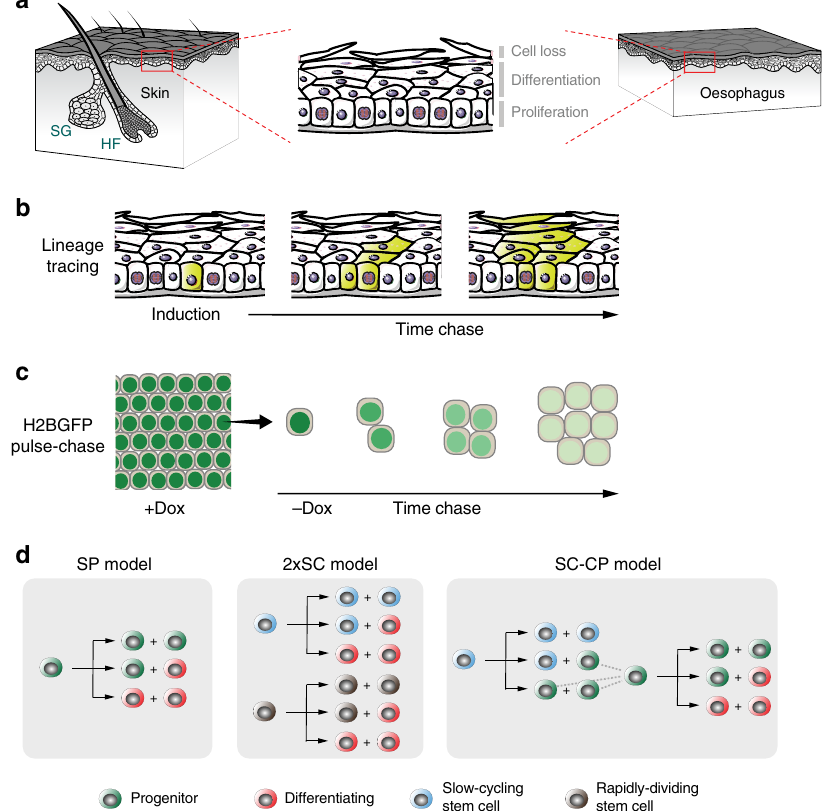
Fig. 1 Quantitative approaches to cell behavior in murine epithelium. a Structure of the strati fi ed squamous epithelia from the interfollicular epidermis (skin) and esophagus of adult mice. Proliferating keratinocytes are located in the basal layer. Upon differentiation they migrate through suprabasal layers until they are ultimately lost by shedding. A balance should be established between cell division and cell loss to guarantee tissue homeostasis. HF, hair follicle; SG, sebaceous gland. b Rationale of genetic lineage tracing. Low-dose induction in transgenic mice allows recombination and conditional labeling of punctuated keratinocyte progenitors in the basal layer. These cells and their progeny remain labeled and can be tracked to study clonal dynamics over time. c Rationale of Histone 2B-GFP (H2BGFP) dilution experiments (a top-down view of the basal-layer plane is sketched). Transgenic-mouse keratinocytes express H2BGFP protein while on doxycycline (Dox) treatment. After Dox withdrawal cycling cells dilute their H2BGFP content with every division, allowing to study cell-proliferation rate. d Different stochastic cell-proliferation models invoked to explain epithelial self-renewal. Branches re fl ect different possible fates for a given proliferating cell upon division. SP: single-progenitor model. 2xSC: two stem-cell model, involving two independent types of proliferating cells dividing at different rates. SC-CP: stem cell-committed progenitor model, involving slow-cycling stem cells underpinning a second population of quickly-dividing